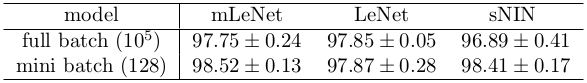
Table from the paper: Towards Understanding Generalization of Deep Learning: Perspective of Loss Landscapes
Table text:
model
mLeNet
LeNet
sNIN
fullbatch(10 5 )
97.75 ± 0.24
97.85 ± 0.05
96.89 ± 0.41
minibatch(128)
98.52 ± 0.13
97.87 ± 0.28
98.41 ± 0.17